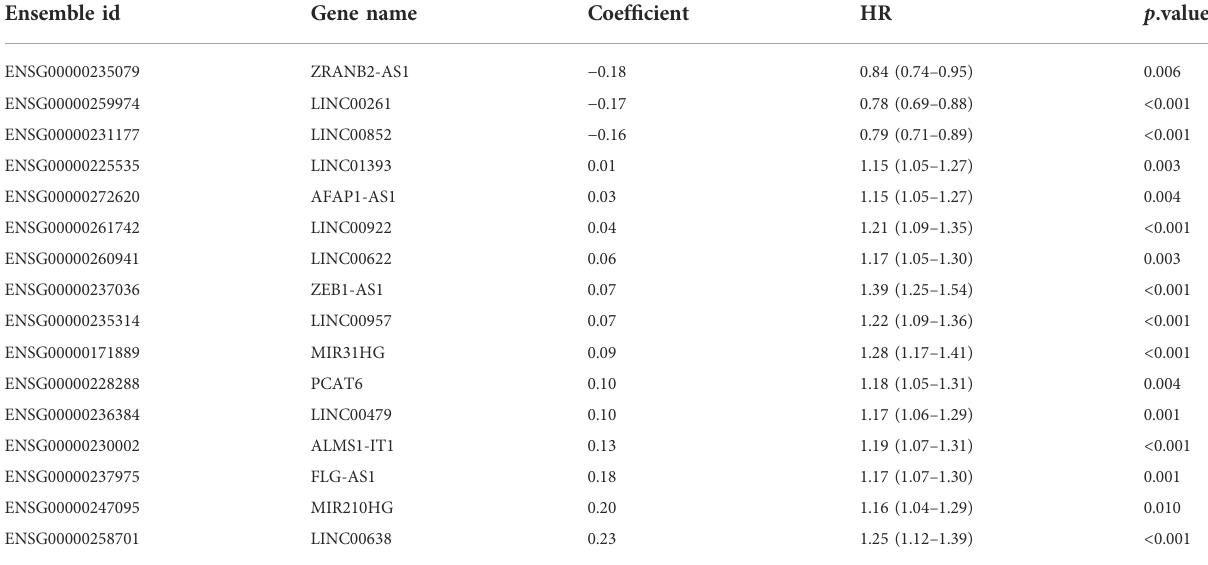
TABLE 2 Sixteen in fl ammation-related lncRNAs with prognostic